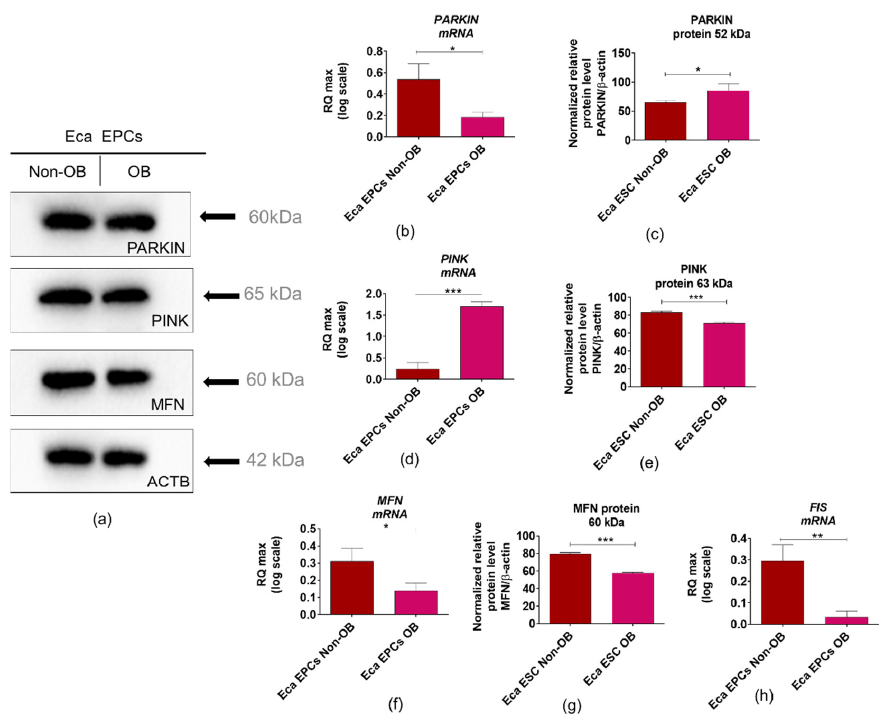
Figure 9. The expression profile of molecular markers associated with mitochondrial dynamics determined for equine endometrial progenitor cells (Eca EPCs) isolated from non-obese mares (non-OB) and obese mares (OB). Parkin RBR E3 ubiquitin-protein ligase (PARKIN), PTEN-induced kinase 1 (PINK1) and mitofusin 1 (MFN1) were determined based on mRNA ( b , d , f ) and protein levels ( a )—representative blots; ( c , e , g )—graphs reflecting the expression of proteins normalized